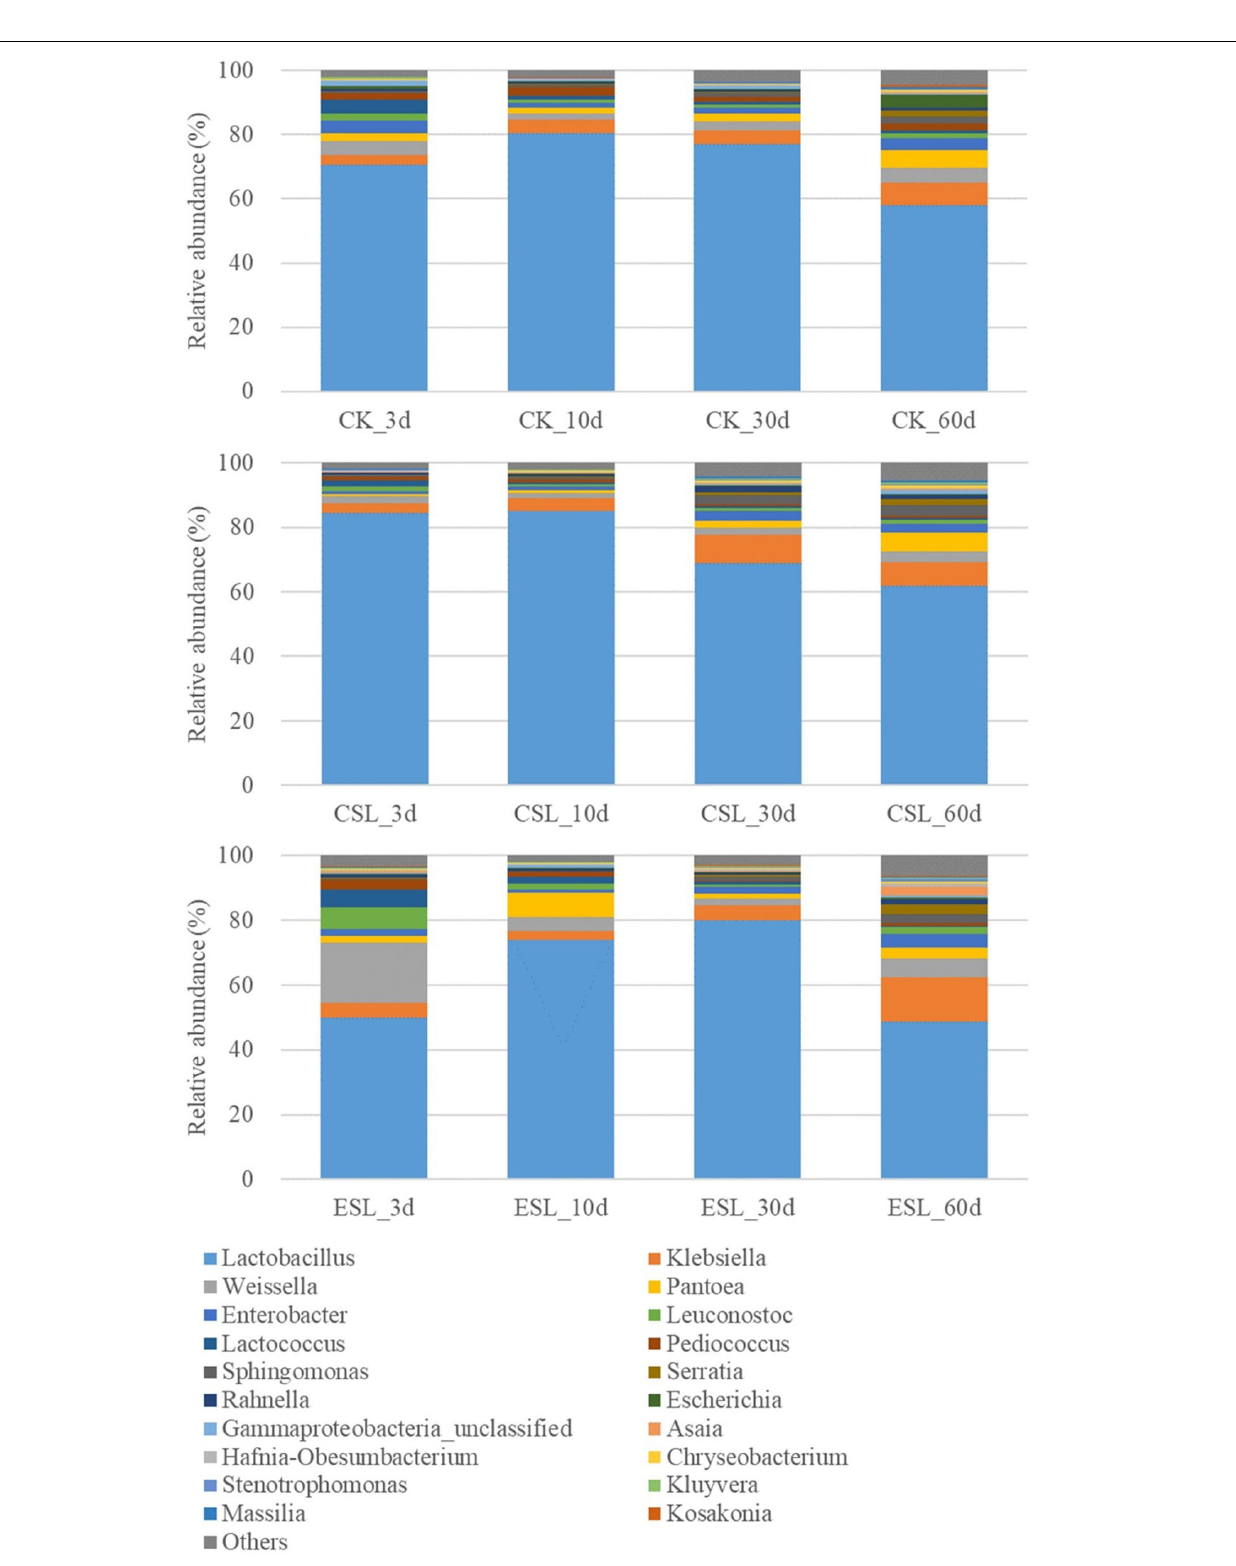
Frontiers in Microbiology |